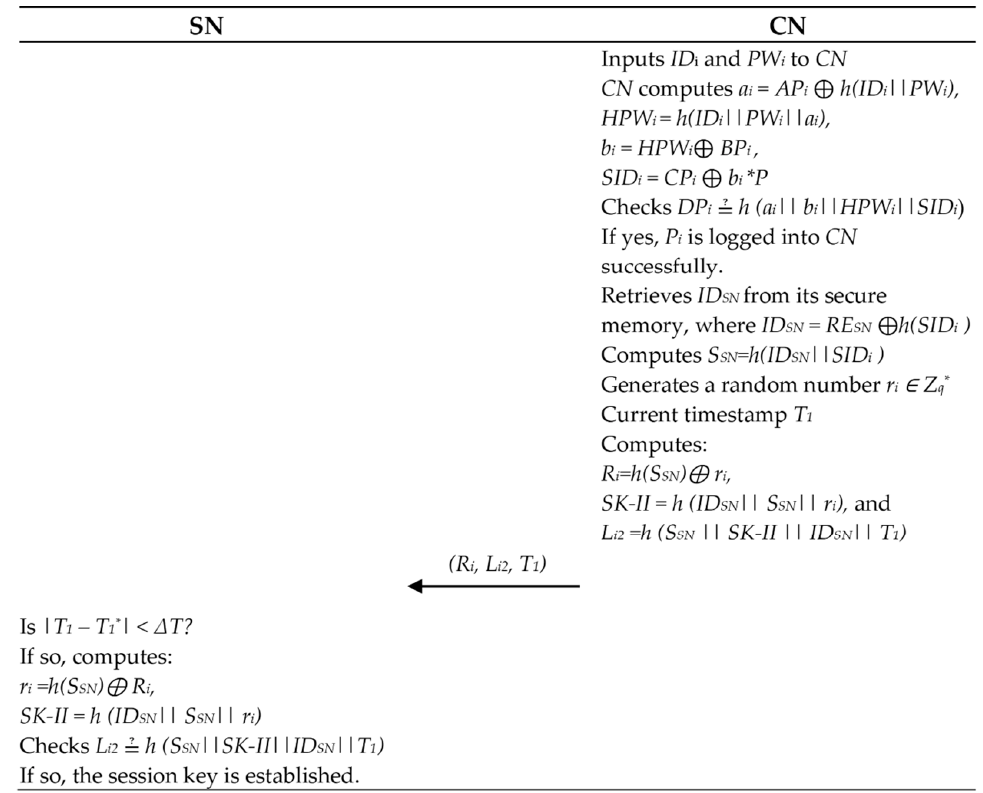
Figure 4. Authentication protocol-II.